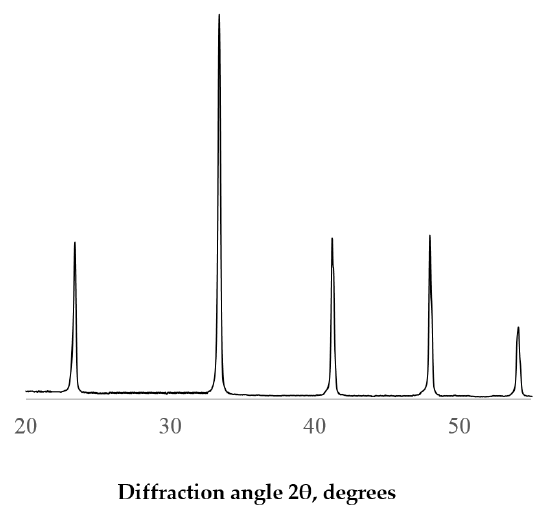
Figure 3. XRD of La 0.85 Yb 0.15 AlO 3 .